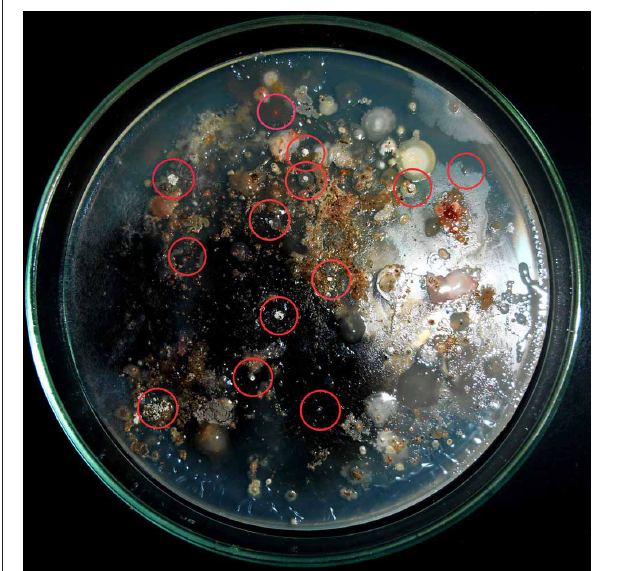
FIGURE 2 | Stamping method employed for isolation of actinomycetes. Appearance of actinomycete like colonies encircled on isolation media stamped with ground soil